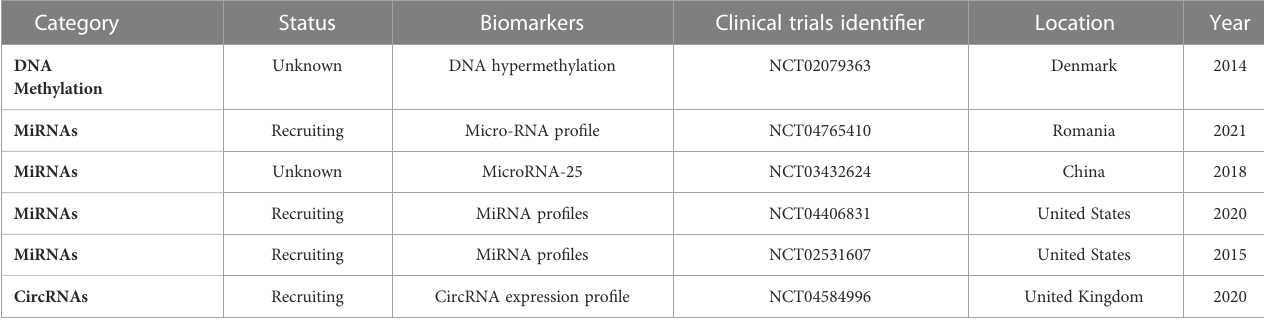
TABLE 2 Clinical trials on epigenetic biomarkers for pancreatic cancer.